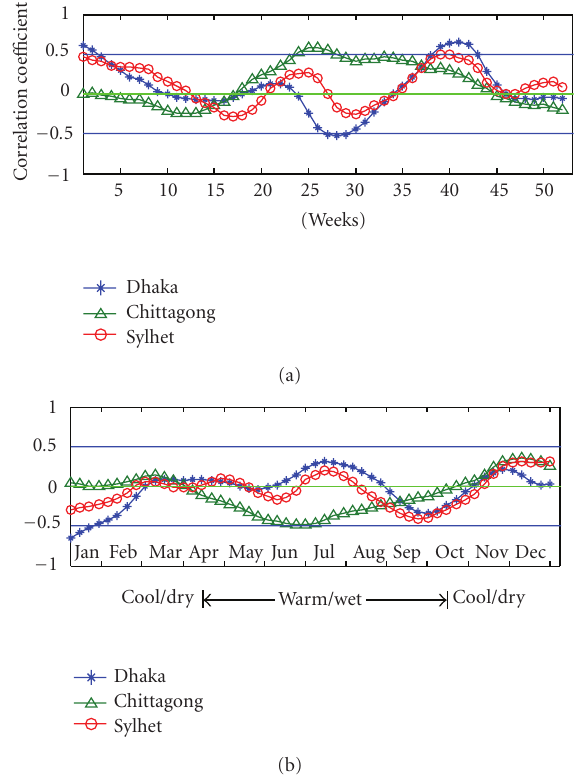
Figure 4: Correlation coe ffi cient dynamics of DY versus (a), TCI and (b)